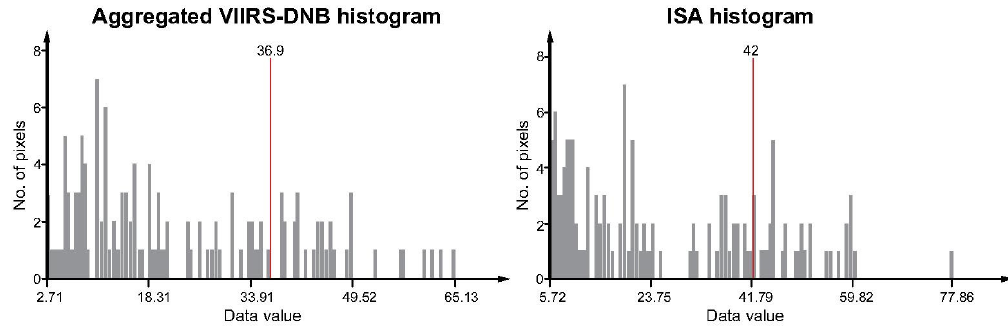
Figure 12. VIIRS-DNB (aggregated) and ISA histograms for the Cuenca city case study.